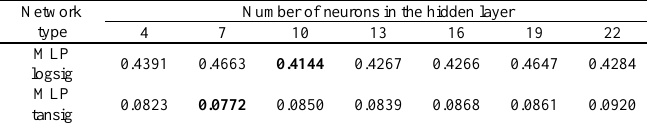
Table 4. Results of MLP networks with two different transfer functions in the output layer with respect to different number of neurons in the hidden layer during training. The boldface subset of the training data.